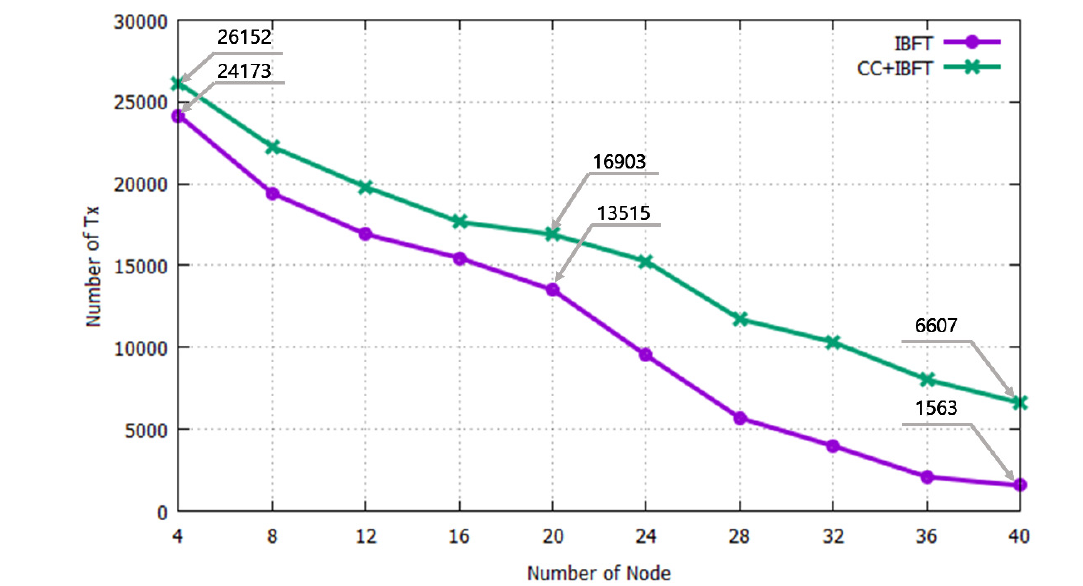
Figure 5. Comparing the amount of transactions between IBFT and CC + IBFT when the transaction generation interval is 10